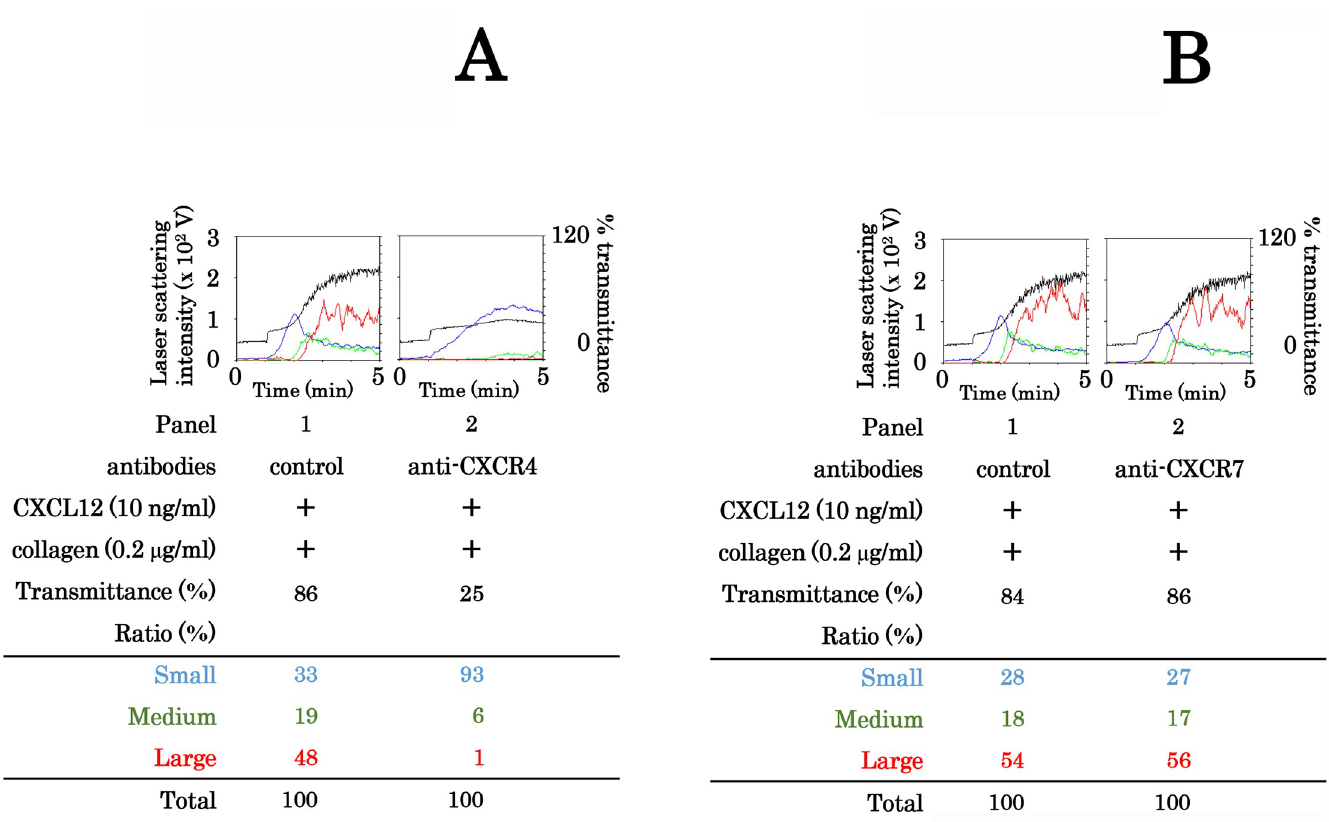
Fig 4. Effect of anti-CXCR4 or anti-CXCR7 monoclonal antibody on the platelet aggregation induced by simultaneous stimulation with collagen and CXCL12 in low doses. PRP was pretreated with 10 μ g/ml of control IgG, anti-CXCR4 monoclonal antibody (A), or anti-CXCR7 monoclonal antibody (B) for 3 min and then simultaneously stimulated by 0.2 μ g/ml of collagen and 10 ng/ml of CXCL12 for 5 min. The reaction was terminated by the addition of ice-cold EDTA solution. The black line indicates the percentage of transmittance of each sample (isolated platelets recorded as 0%, and platelet-poor plasma recorded as 100%). The blue line indicates small aggregates (9–25 μ m); green line, medium aggregates (25–50 μ m); red line, large aggregates (50–70 μ m). The lower panel presents the distribution (%) of aggregated particle size as measured by laser-scattering.